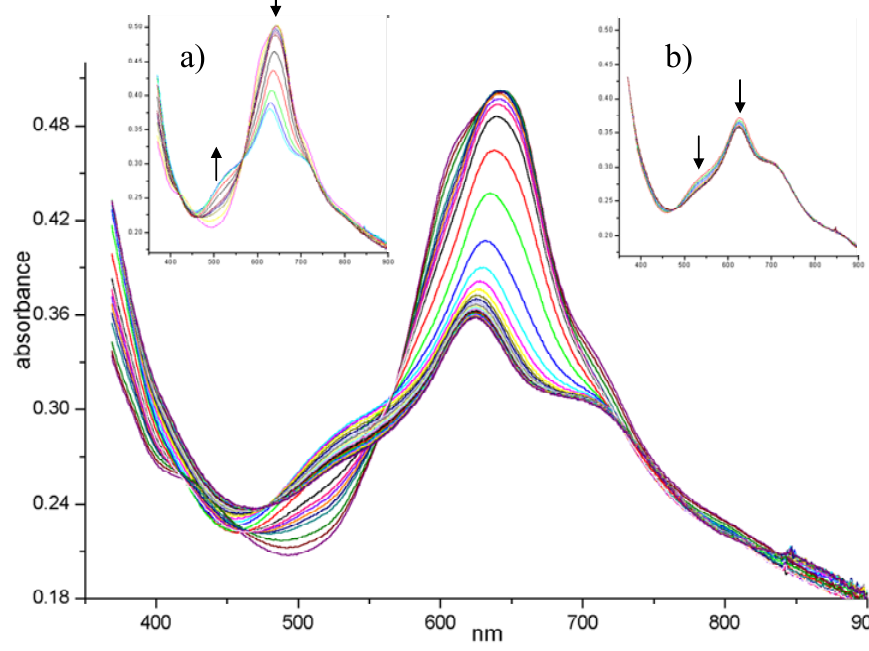
Figure 10. UV-Visible spectra of a 90 nm thick (PcRu) 92 ppm of NO gas in dry air; inset a) first 90 min of exposure; inset b) from 90 to 280 min 2 of